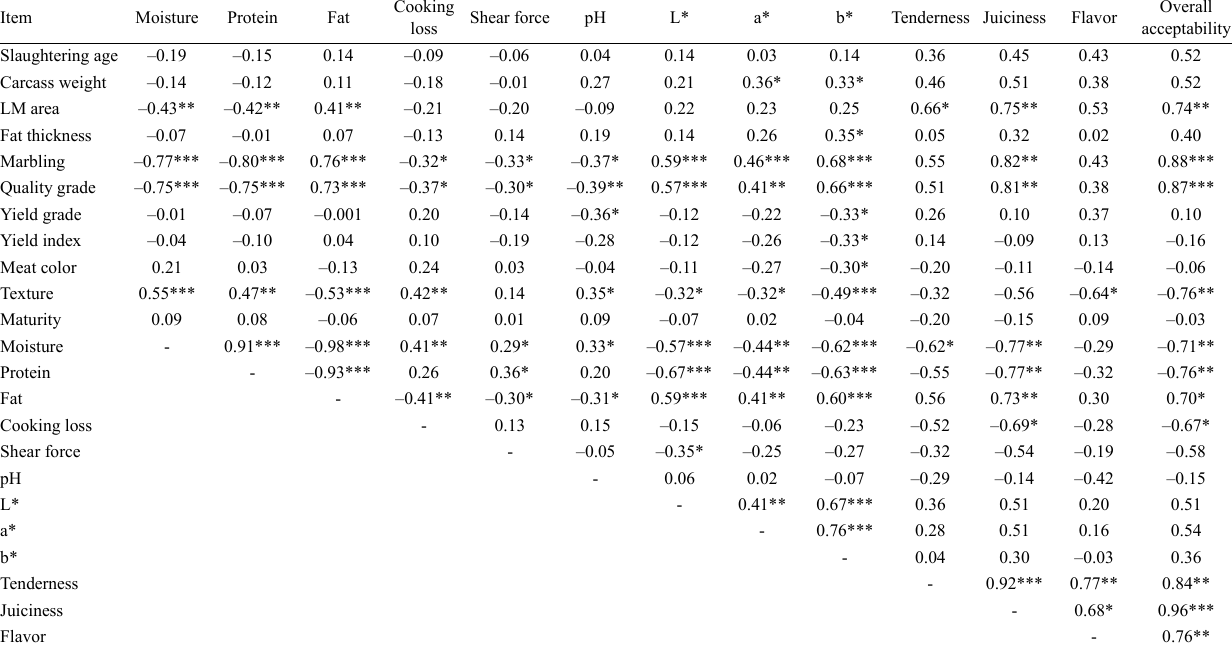
Cooking Shear force pH b* Tenderness Juiciness Flavor loss